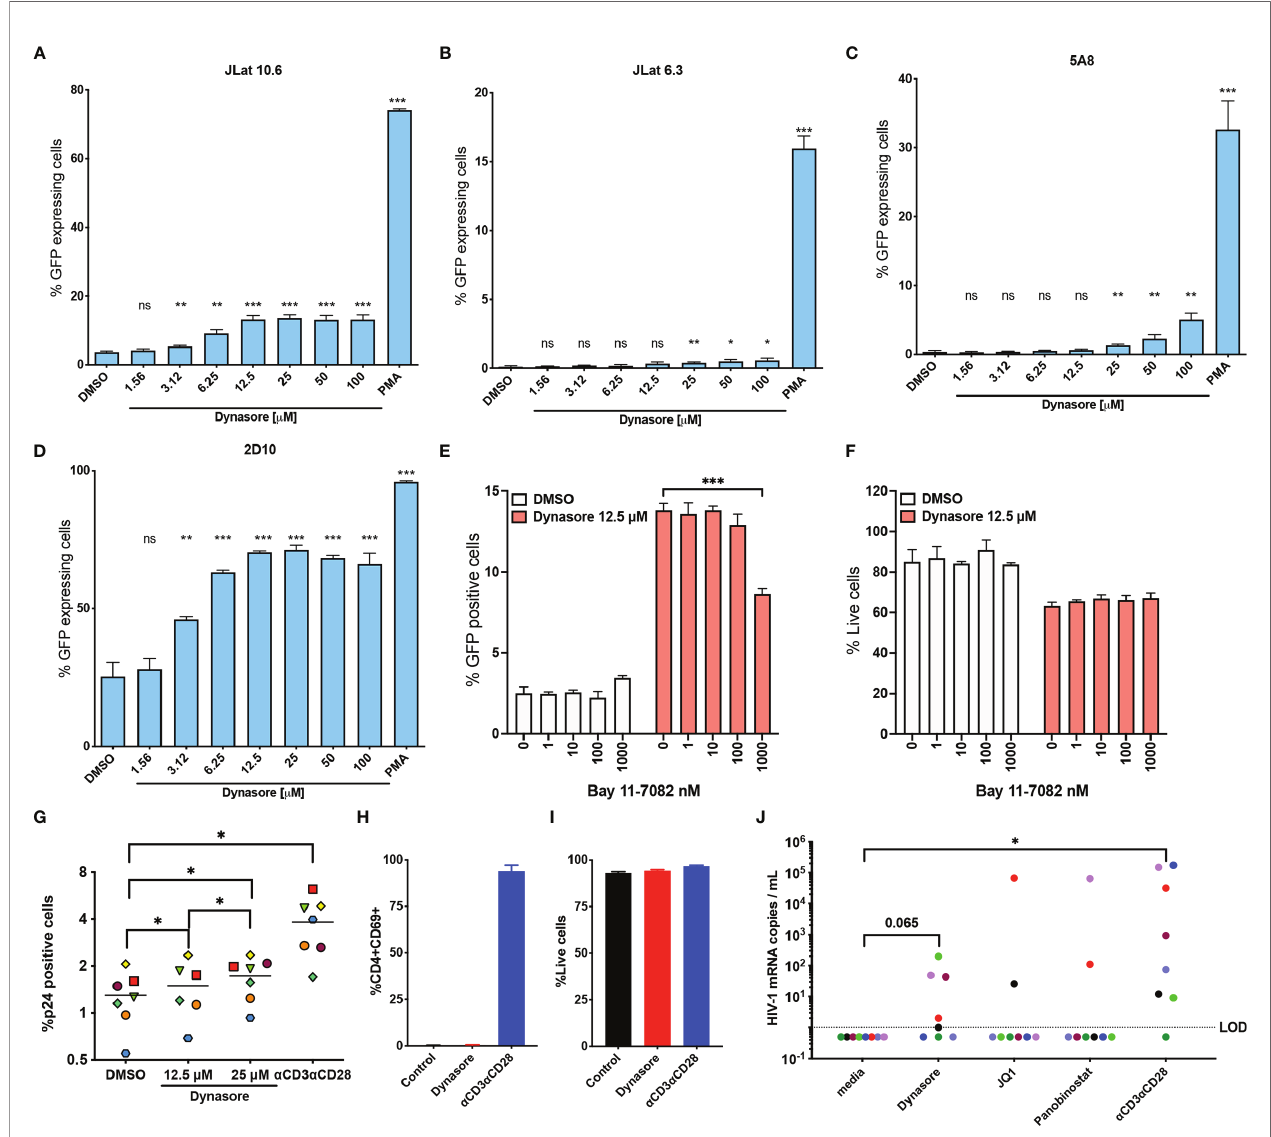
FIGURE 1 | Dynasore reactivates latent HIV-1 in in vitro models of HIV-1 latency and cells isolated from aviremic HIV participants. (A) J-Lat 10.6, (B) J-Lat 6.3, (C) 5A8 and (D) 2D10 cell lines were treated with increasing concentrations of Dynasore or with 5 ng/ml PMA. Percentage of cells expressing GFP was assessed by fl ow cytometry. Bar graph corresponds to mean and standard deviation of experiments performed in triplicates. Signi fi cance was calculated by unpaired t test analysis. J-Lat10.6 was tested in their ability to reactivate latent HIV-1 with Dynasore in the presence of the NF- k B inhibitor Bay 11-7082. % GFP positive cells (E) and viability (F) were measured by fl ow cytometry. Data are represented as mean of triplicate replicates. Unpaired t-test relative to no inhibitor was used to calculate p-values. (G) Latently infected cultured T CM were treated with solvent DMSO, 12.5 m M and 25 m M Dynasore or a CD3/ a CD28 beads. Percentage of cells expressing p24-gag was assessed by fl ow cytometry. Experiments were done with cells generated from 7 different donors. Each symbol corresponds to a different donor. Mean is indicated with a horizontal line. Statistically signi fi cant p values determined by using Wilcoxon matched pairs signed rank test analysis relative to media control. Memory CD4 T cells from three HIV-negative donors were treated with 12.5 m M Dynasore and levels of CD4 activation (H) and toxicity (I) were measured at 48h by fl ow cytometry. (J) Viral reactivation mediated by 12.5 m M Dynasore, 200 nM JQ-1, 10 nM Panobinostat or a CD3/ a CD28 was measured in cells isolated from 8 aviremic PLWH using the REVEAL assay. Wilcoxon matched-pairs signed rank test analysis relative to media control was used to calculate p-values. (*< 0.05, **< 0.01, ***< 0.001, ns, not signi fi